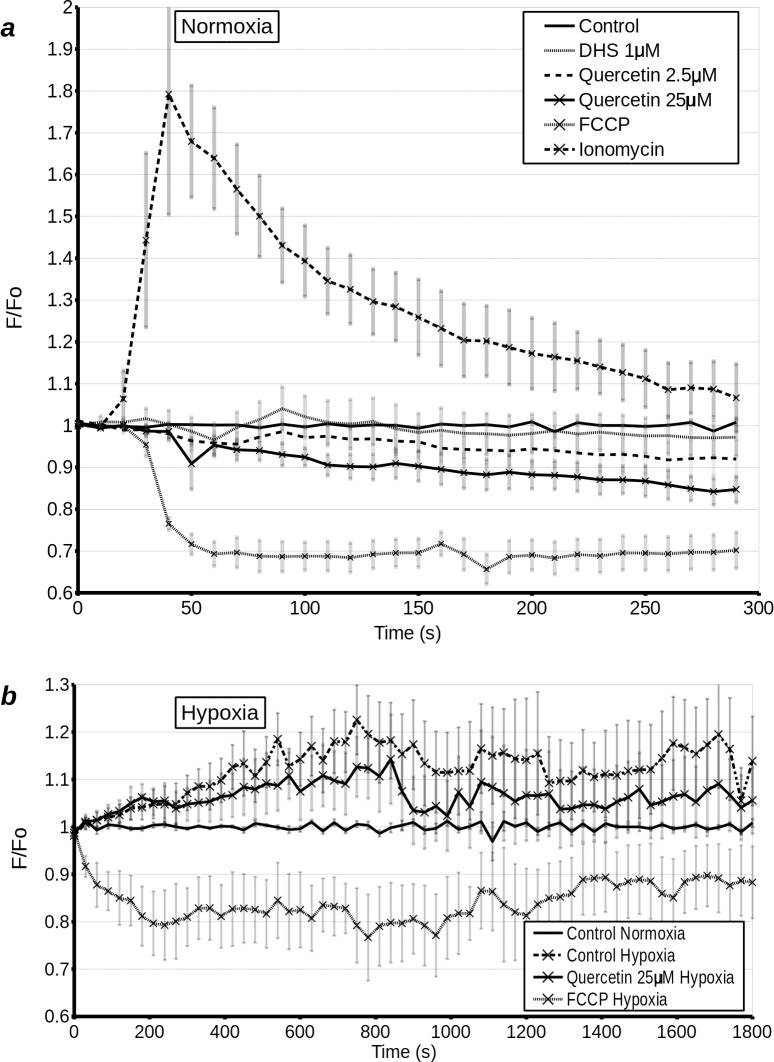
(a) Mitochondrial [Ca++] measured at 10 s intervals over 300 s by wide-field microscopy in H9c2 cells transfected with mGECO-1. Cells were treated with DMSO (control), 1 μM DHS (D1), 2.5 μM quercetin (Q 2.5), 25 μM quercetin (Q 25), 5 μM FCCP, or 1 μM ionomycin (Iono) 20 s after the start of the experiment. (b) Mitochondrial [Ca++] measured at 30 s intervals over 30 min (1800 s) by wide-field microscopy in H9c2 cells transfected with mGECO-1, following 1 h normoxia or 1 h hypoxia. Cells were treated with DMSO (control normoxia/hypoxia), 25 μM quercetin or 5 μM FCCP immediately prior to the start of recording.